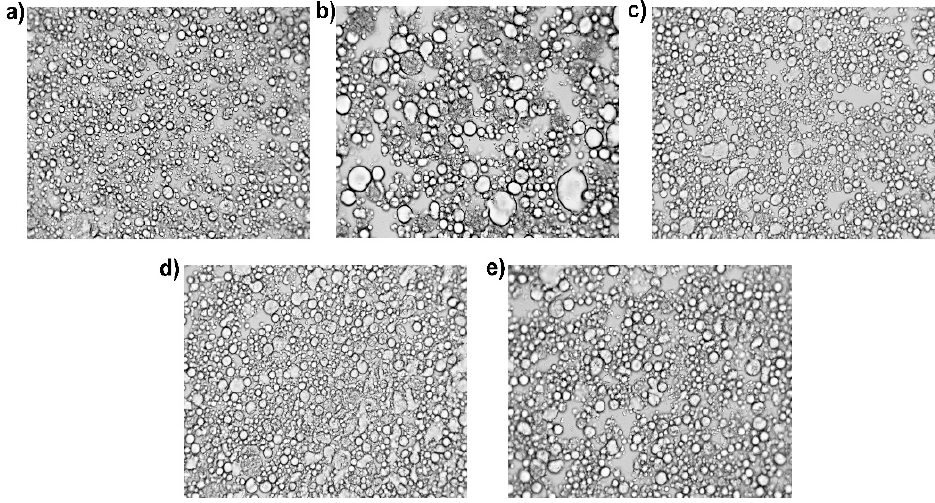
Figure 2. Emulsion microstructure for: EM1 ( a ), EM2 ( b ), EM 3 ( c ), EM4 ( d ), and EM5 ( e ) after 72 h from preparation (G × 400).